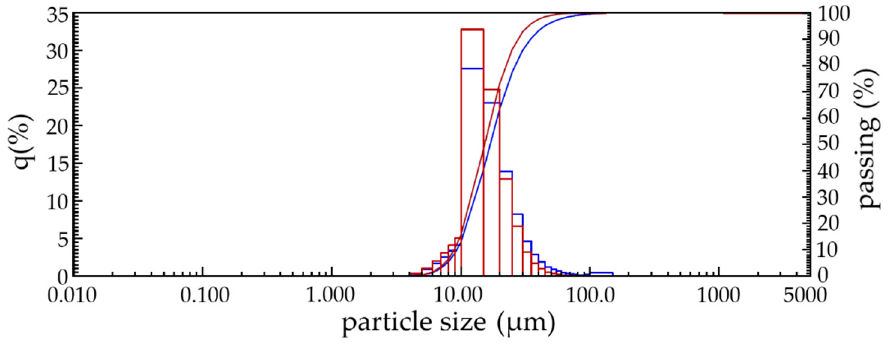
Figure 1. Dispersion composition and curve of total lime dust particles: −−− before quenching; −−− after quenching.